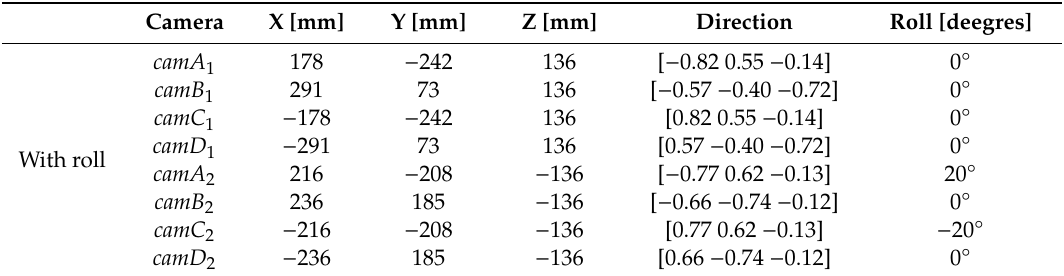
Table 8. Cartesian coordinates of the camera positions, direction of the optical axis expressed as a unit vector, roll angle of the